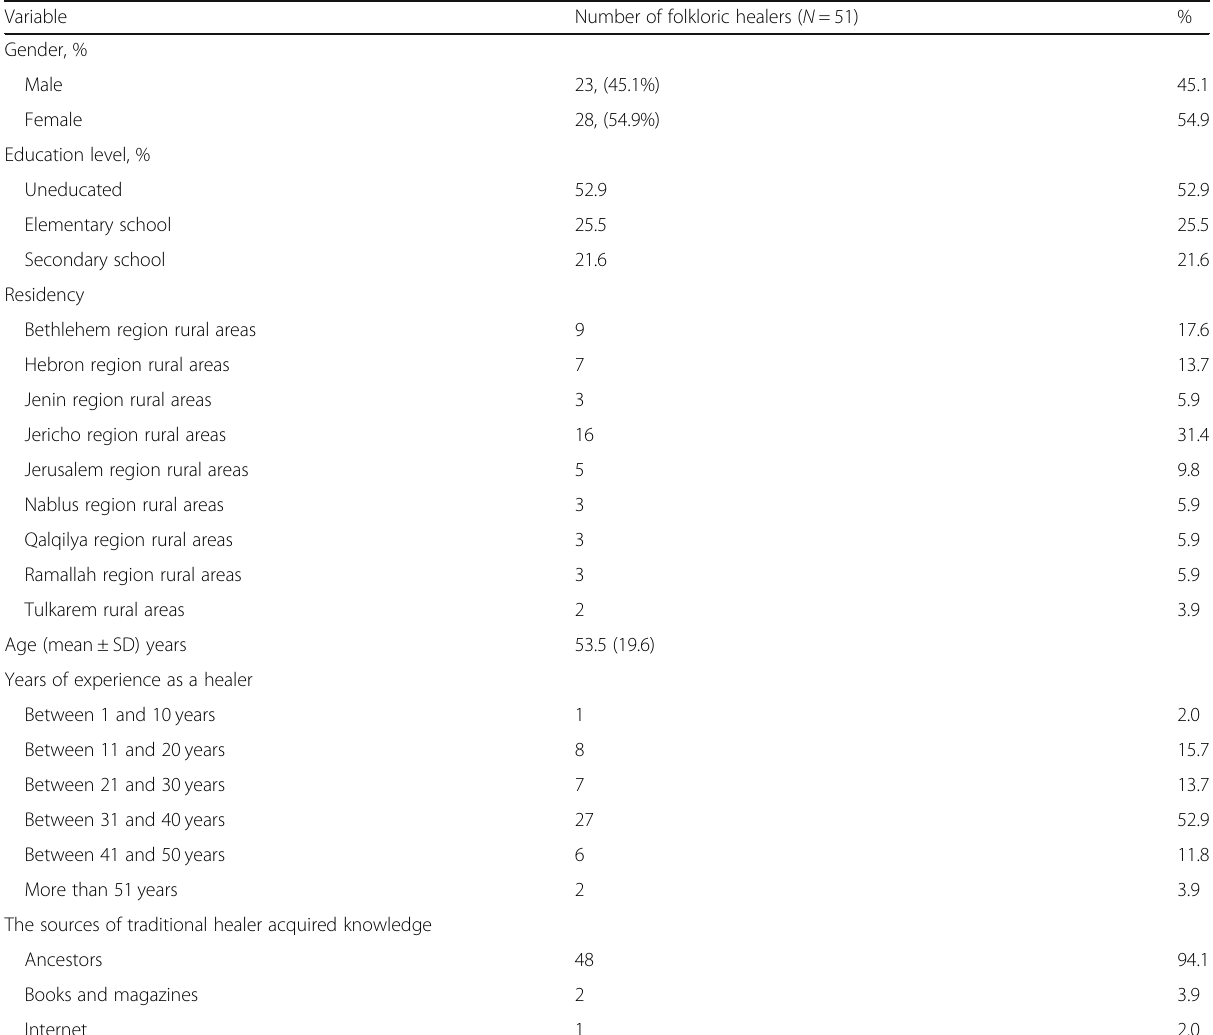
Table 1 Social-demographic factors related to the informants Variable Number of folkloric healers ( N =